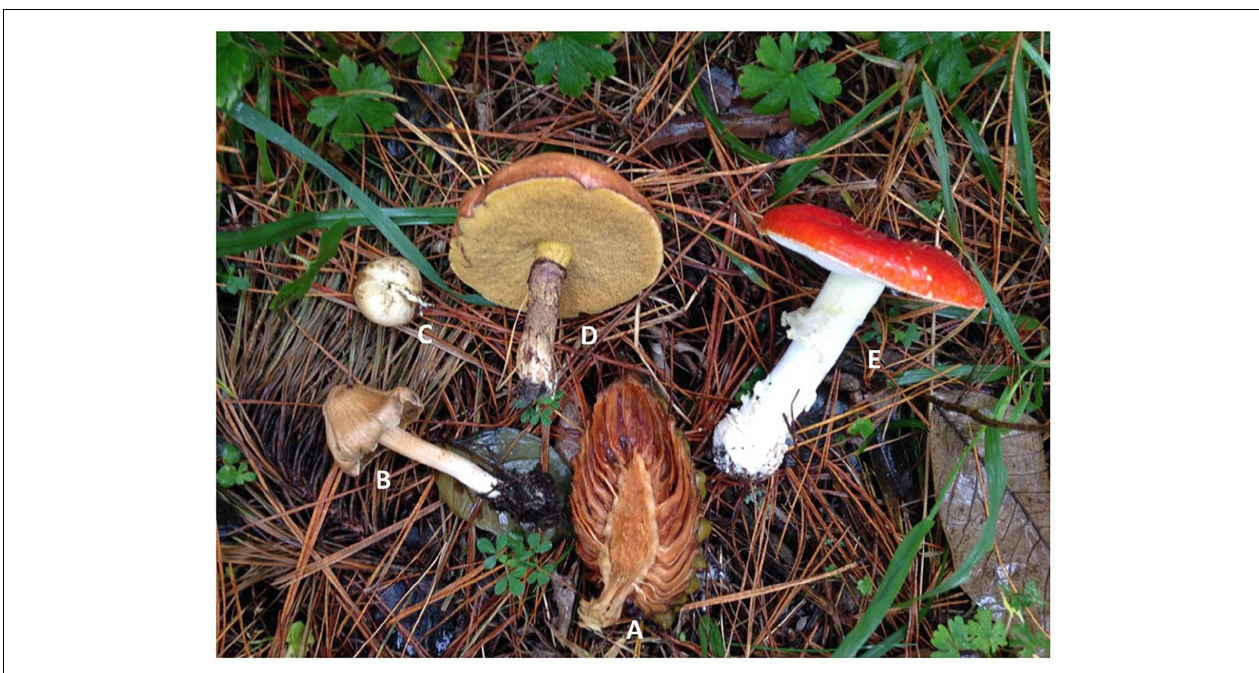
FIGURE 2 | Ectomycorrhizal partners commonly co-occurring in exotic pine forests in Australia. (A) cone (split in half) of a common host plant, Pinus radiata, and four ectomycorrhizal fungi: (B) Inocybe sindonia, (C) Rhizopogon pseudoroseolus, (D) Suillus luteus, and (E) Amanita muscaria. Photo by R. Vilgalys, Blue Mountains near Sydney,